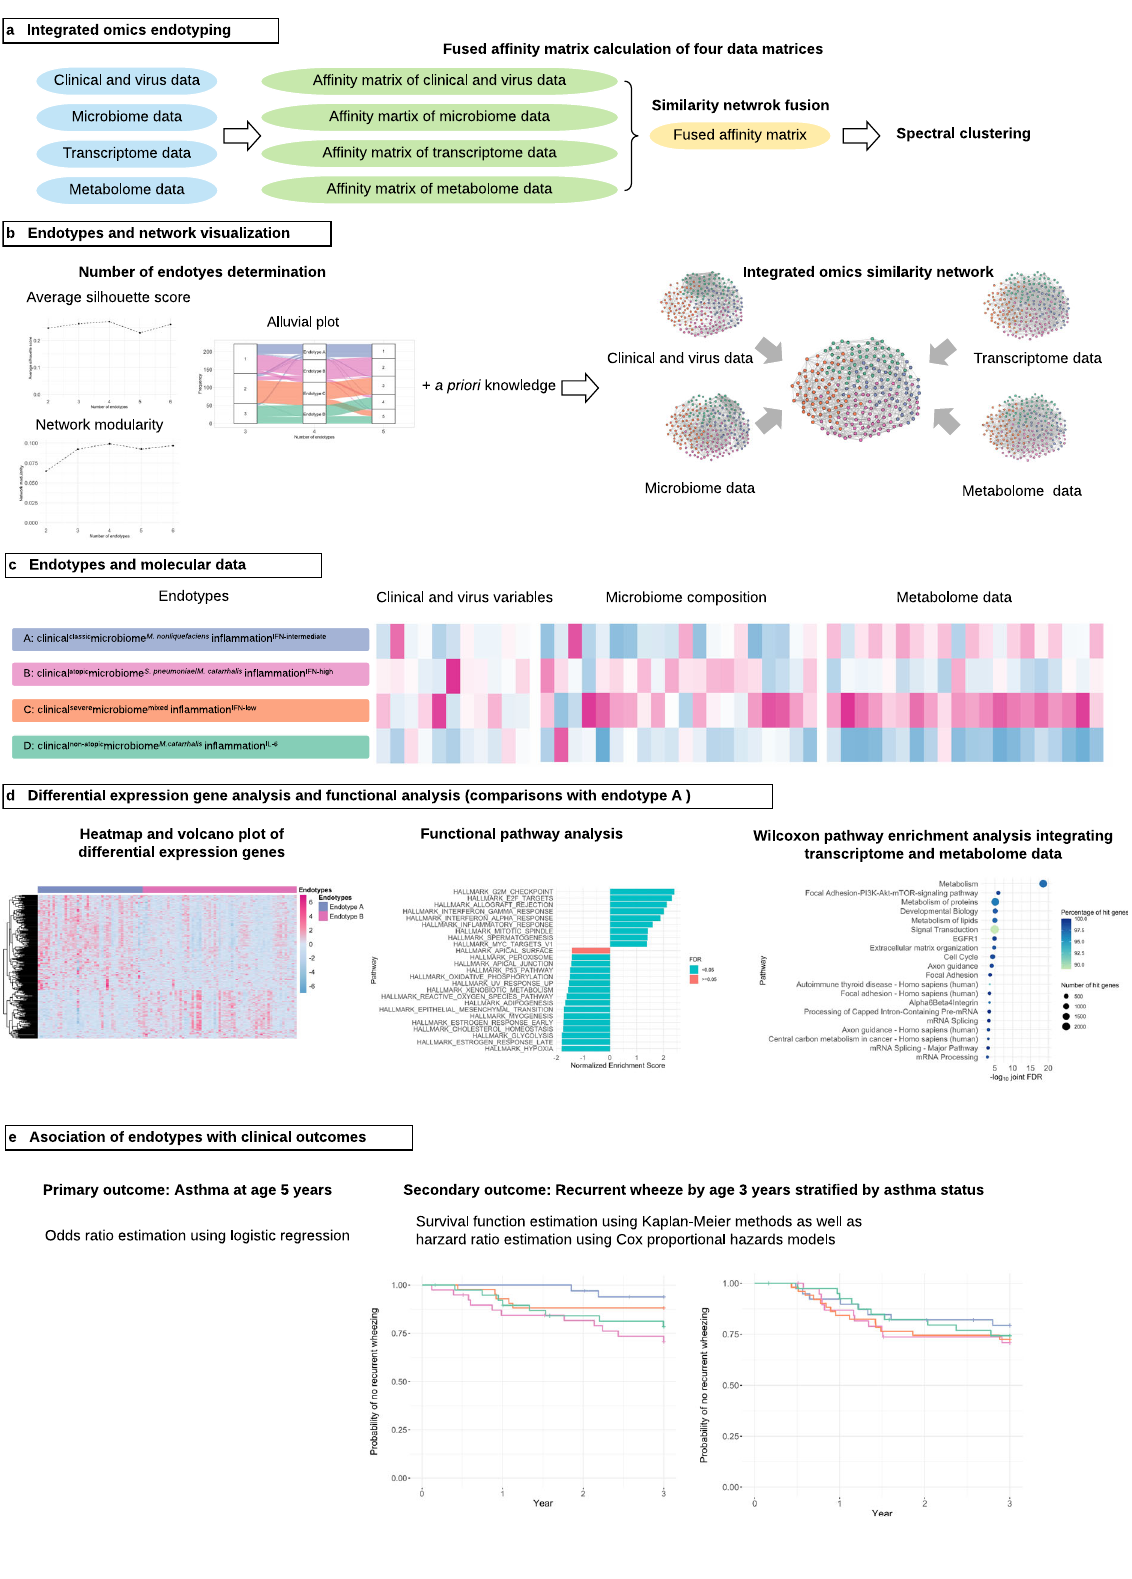
Endotypes had differential risks of developing asthma and recurrent wheeze . To examine their longitudinal association with clinical outcomes, we compared the outcome risks between endotype A (clinically “ classic ” bronchiolitis) and each of the other endotypes. Compared with endotype A infants, endotype B